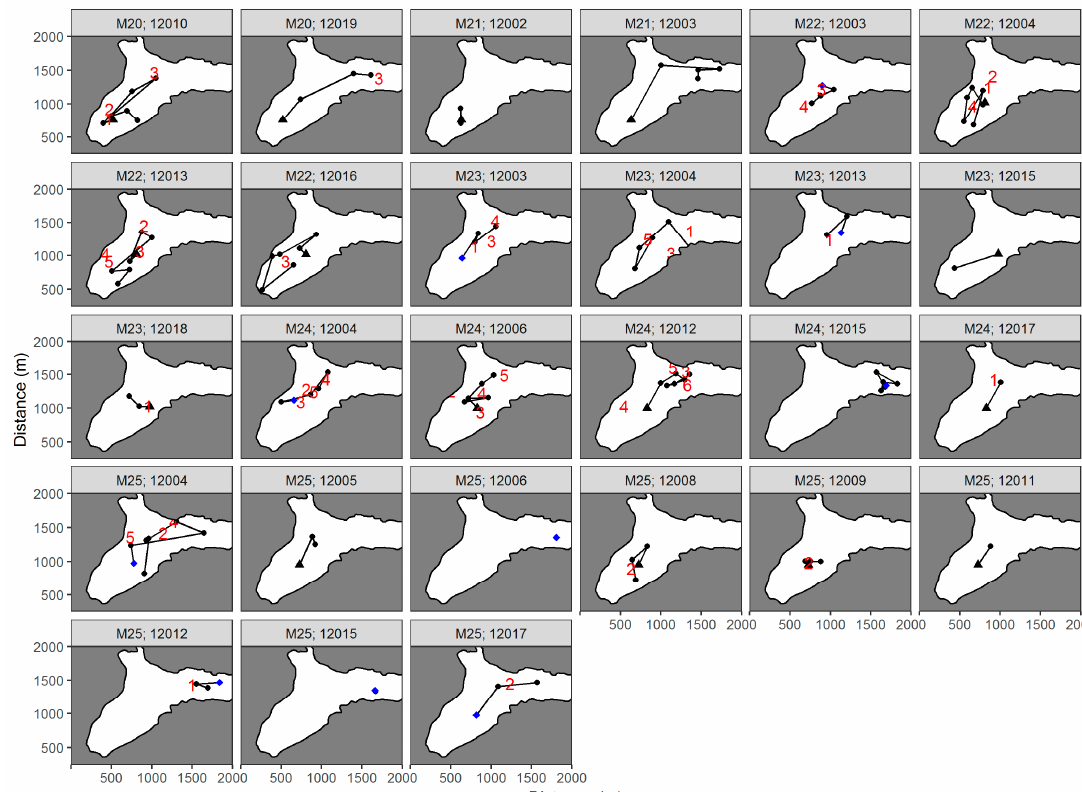
Figure A3. Comparison of the location estimates of juvenile Chinook salmon tagged with acoustic transmitters and located using an autonomous underwater vehicle and vessel-based tracking in Big Port Walter, Alaska. The site where the fish were either released (black triangle) or first located for fish released during a previous mission (blue diamond) are indicated. Subsequent AUV locations are represented by black dots. Vessel-based location estimates are designated by numbers that correspond to the sequential order of the paired AUV estimates (e.g., the numbers 2 and 4 correspond to the second and fourth AUV